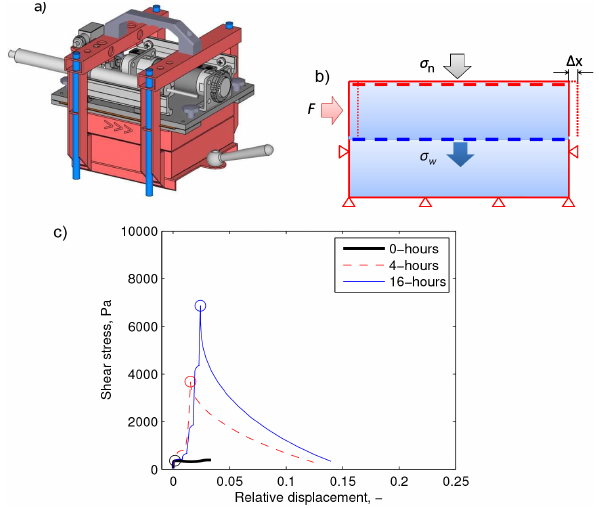
Figure 1. (a) Schematic illustration of the apparatus and (b) of the inner part of the apparatus with a snow specimen inside (see text for details); (c) stress–relative displacement curves showing examples of failure stress (shown by circles) increase after 0, 4 and 16h of sintering ( σ n =